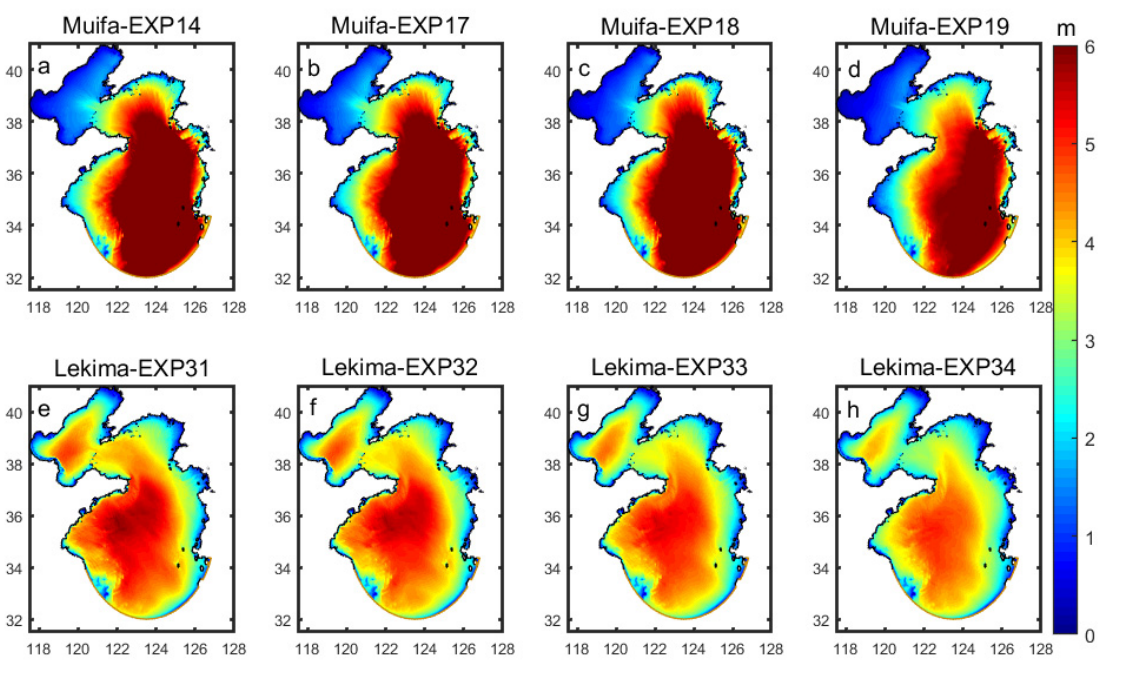
Figure 15. Spatial distribution of a significant wave height when the translation speed was ( a ) 7.5 km/h, ( b ) 15 km/h, ( c ) 30 km/h, and ( d ) 60 km/h based on Typhoon Muifa and ( e ) 7.5 km/h, ( f ) 15 km/h, ( g ) 30 km/h, and ( h ) 60 km/h based on Typhoon Lekima.